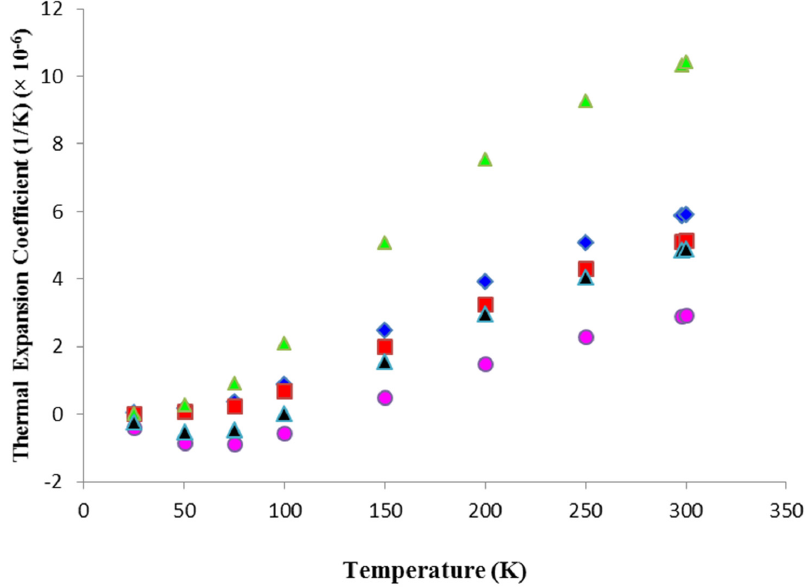
Figure 27. Thermal expansion coefficient as a function of absolute temperature for the uniaxial laser materials Al 2 O 3 along the a (red) and c axes (blue) [60], ZnO along the a (black) and c (pink) axes [60], and for the isotropic laser material MgO (green) [60].